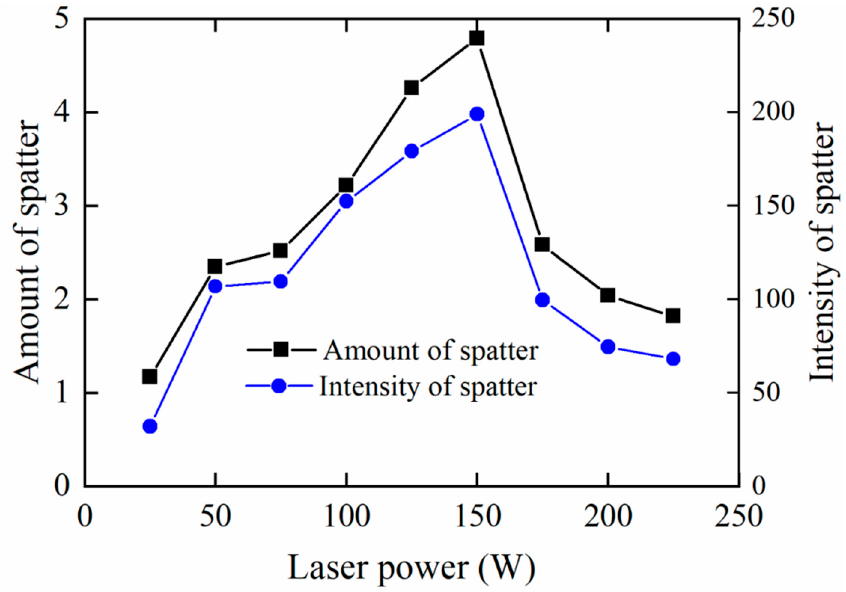
Figure 10. The number and intensity of spatter change with laser power during the SLM (the scaning speed is 30 mm/s).